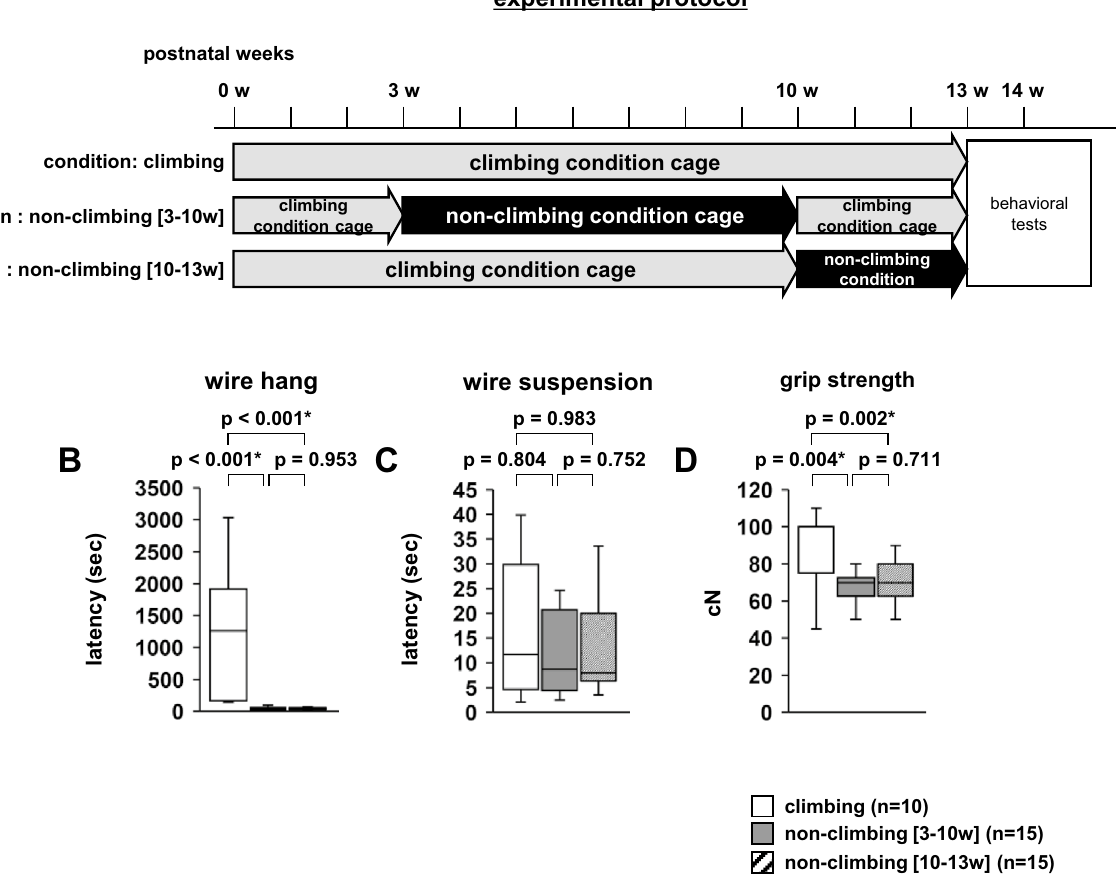
Figure 7. The effect of grid-climbing prevention on physical characteristics in adulthood. ( A ) Experimental time schedules: non-climbing [3–10 weeks] mice are housed in cages with wire grid lids covered with Plexiglas from 3 to 10 weeks of age and housed in standard cages from 10 to 13 weeks of age. Non-climbing [10–13 weeks] mice are housed in standard cages until 10 weeks of age and housed in cages with wire grid lids covered with Plexiglas from 10 to 13 weeks of age. Subsequently, behavioral tests were performed. The latency to fall in the wire hang test ( B ) and wire suspension test ( C ), and grip strength test ( D ). Data are presented as box plots ( B – D ). Statistical significance is represented by asterisks: * p < 0.05, + p < 0.1. P -values were calculated